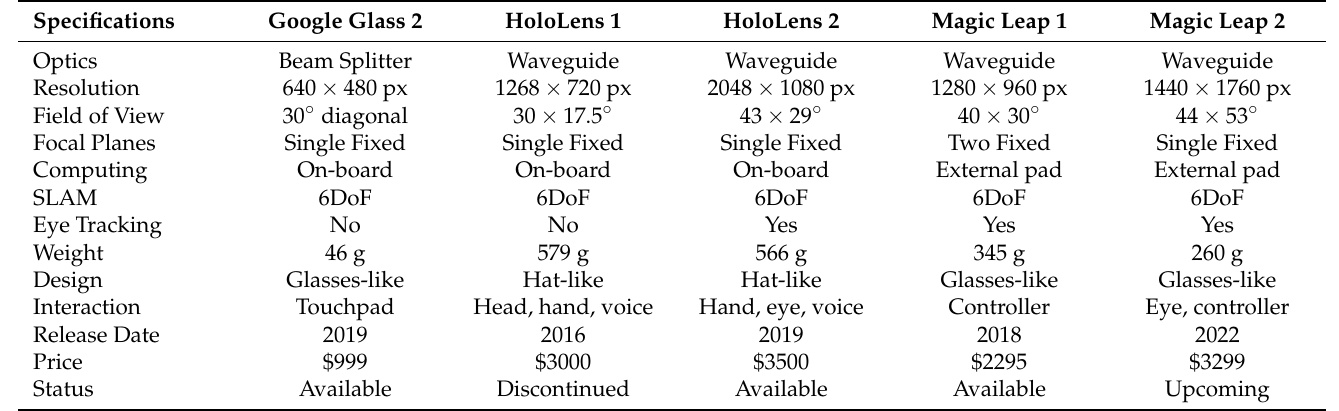
Table 1. Summary of technical specifications for commercially available optical see-through head- mounted displays.